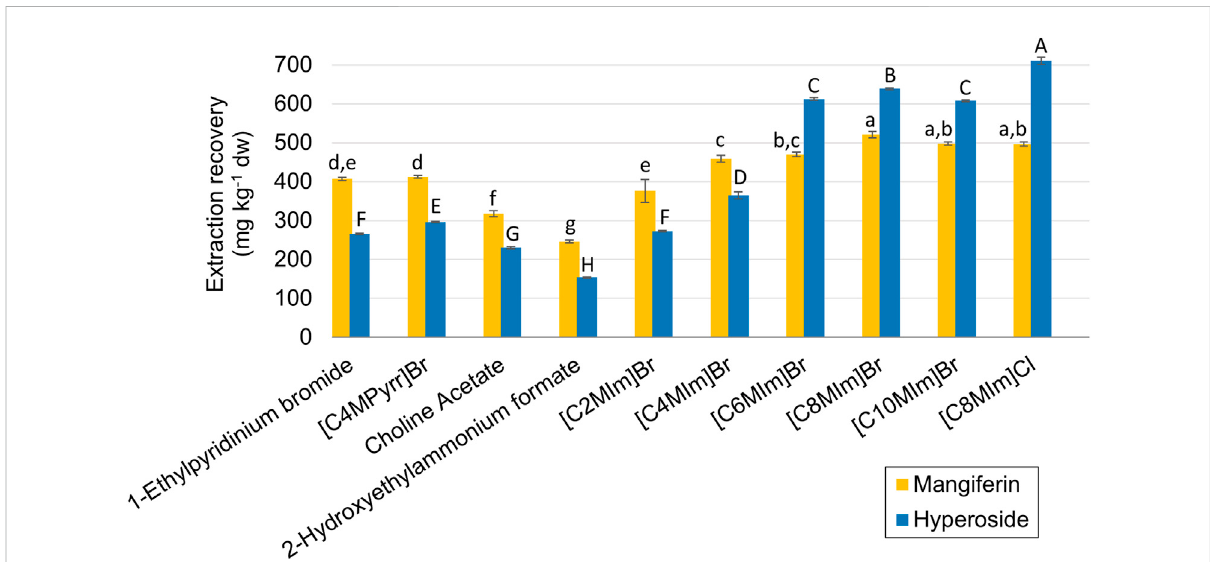
FIGURE 1 Extraction recoveries of mangiferin and hyperoside for the screening experiments. Error bars are expressed in terms of the standard deviation from the triplicates for each experiment. The letters represent the statistical differences between the averages according to the Tukey test ( p < 0.05) for mangiferin (lowercase) and hyperoside (uppercase).